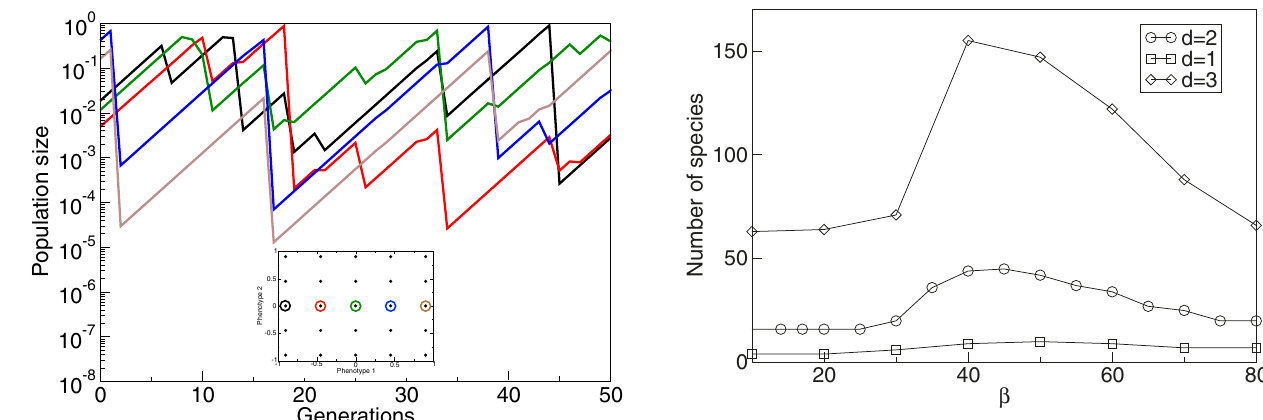
Fig. 4 Examples of population dynamics of 5 neighboring phenotypes in a community consisting of the 25 phenotypes. The whole community is indicated by color in the inset. Parameter values are β = 30, λ = 1.6, and σ = 0.5, which corresponds to the right-most square with more than α 1 species in Fig. 3. Dimension of phenotype space is d = 2. With equilibrium population dynamics ( β = 1) the 25 phenotypes cannot coexist. Note that the population dynamics of immediate neighbours are